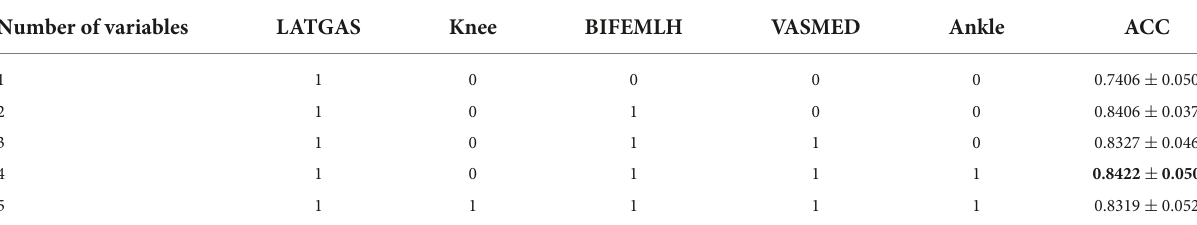
TABLE 3 Variable combinations for node